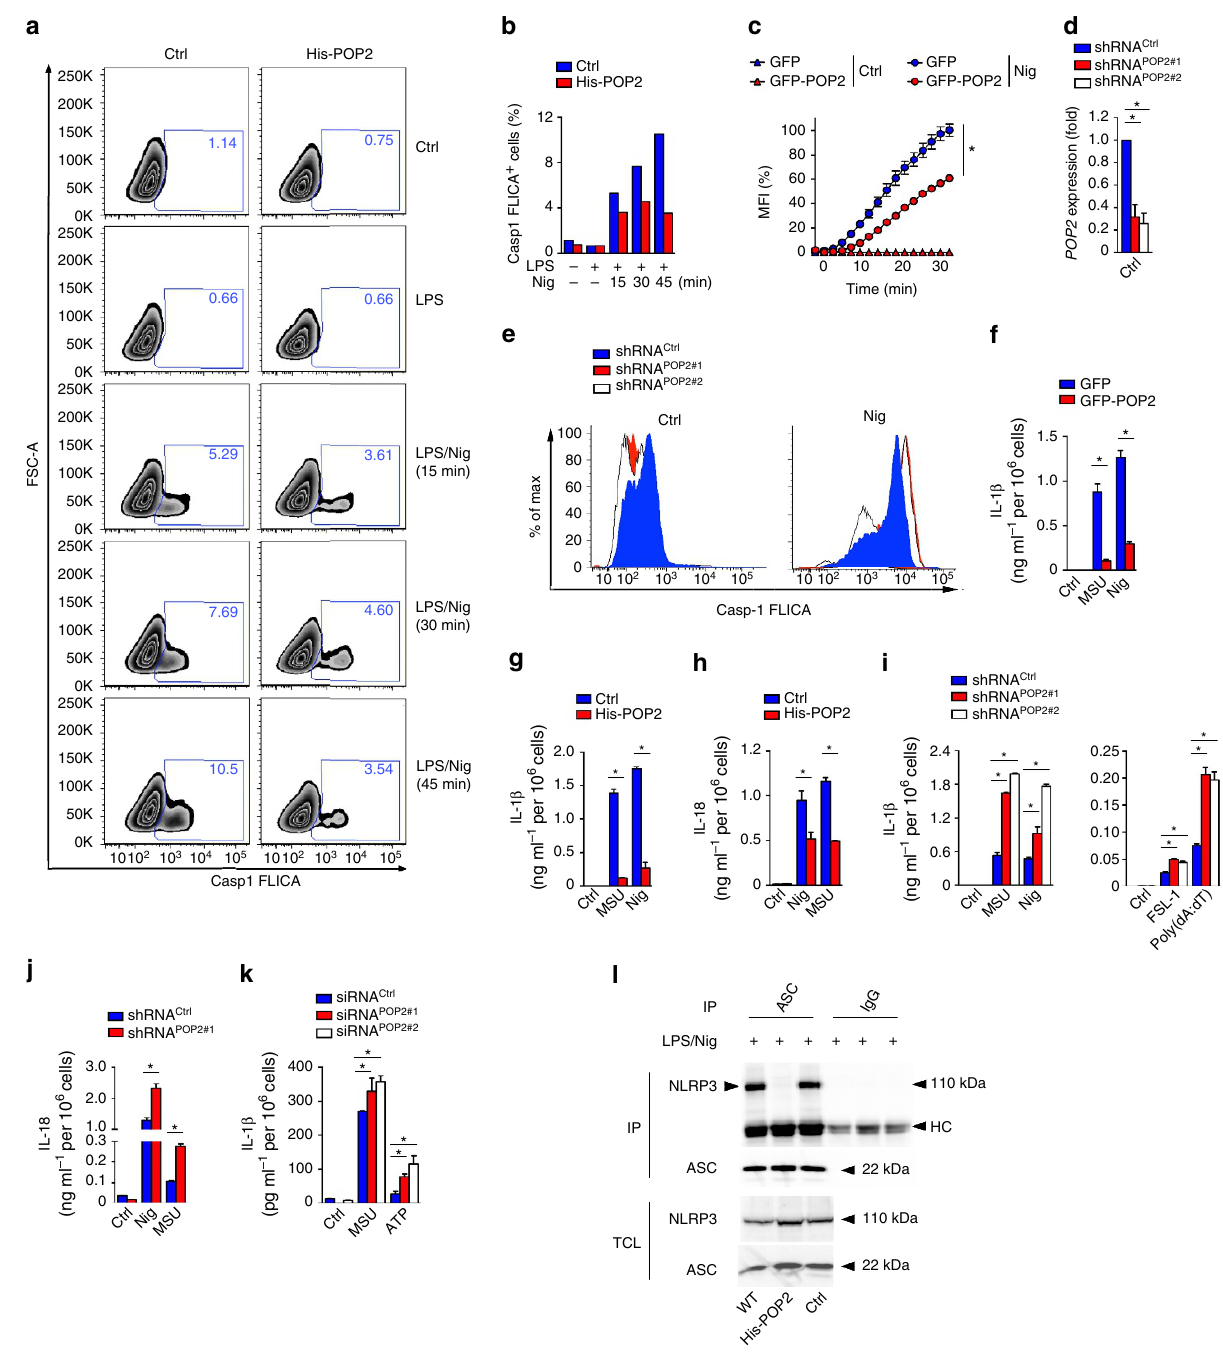
Figure 4 | POP2 inhibits inflammasome activation in human macrophages. ( a , b ) Flow cytometric quantification of active caspase-1 in control (Ctrl) and His-POP2 stably expressing THP-1 cells in response to nigericin (Nig) treatment for the indicated times in LPS-primed cells, indicating the % FLICA þ live, single cells showing ( a ) contour plots and ( b ) quantification. ( c ) Kinetic microplate assay of PI uptake by THP-1 cells stably expressing GFP or GFP-POP2 in response to LPS priming followed by nigericin treatment. ( d ) Real-time PCR analysis of POP2 transcripts in stable control (shRNA Ctrl ) and two independent POP2 shRNA (shRNA POP2#1 and shRNA POP2#2 )-expressing THP-1 cells presented as fold compared to control shRNA cells. ( e ) Flow cytometric quantification of active caspase-1 by FLICA assay in LPS-primed POP2-silenced THP-1 cells in response to nigericin (45min). ( f – j ) Analysis of culture SN for ( f , g , i ) IL-1 b and ( h , j ) IL-18 release by ELISA in LPS-primed ( f ) GFP and GFP-POP2-stable THP-1 cells, ( g , h ) control and His-POP2-stable cells and ( i , j ) control and POP2 shRNA-expressing THP-1 cells in response to the indicated activators. ( k ) Primary human macrophages were transfected with a scrambled control or two POP2-specific siRNAs were primed with LPS, and culture SNs were analysed for secreted IL-1 b release in response to MSU crystals and ATP. ( l ) Immunoprecipitation (IP) of ASC or control immunoglobulin G (IgG) from LPS-primed and nigericin-treated WT, control and His-POP2-stable THP-1 cells, followed by immunoblot analysis alongside TCL. HC indicates the antibody heavy chain. Three independent repeats were performed for each experiment. Significance was calculated by a standard two-tailed unpaired t -test and error bars represent s.e.m., * P o